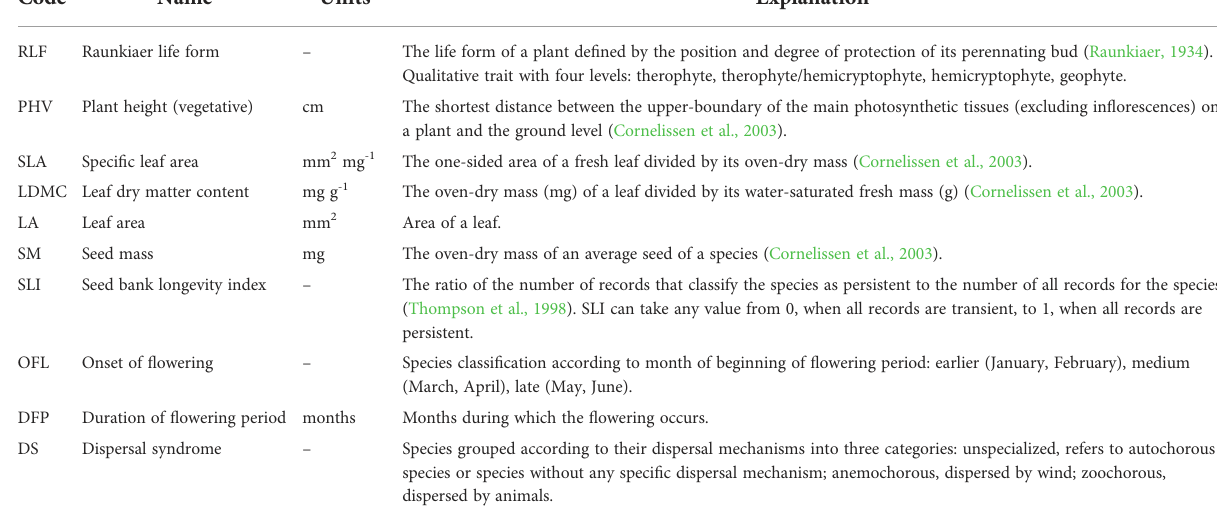
TABLE 1 Brief description of the functional traits used tocompute the functional diversity